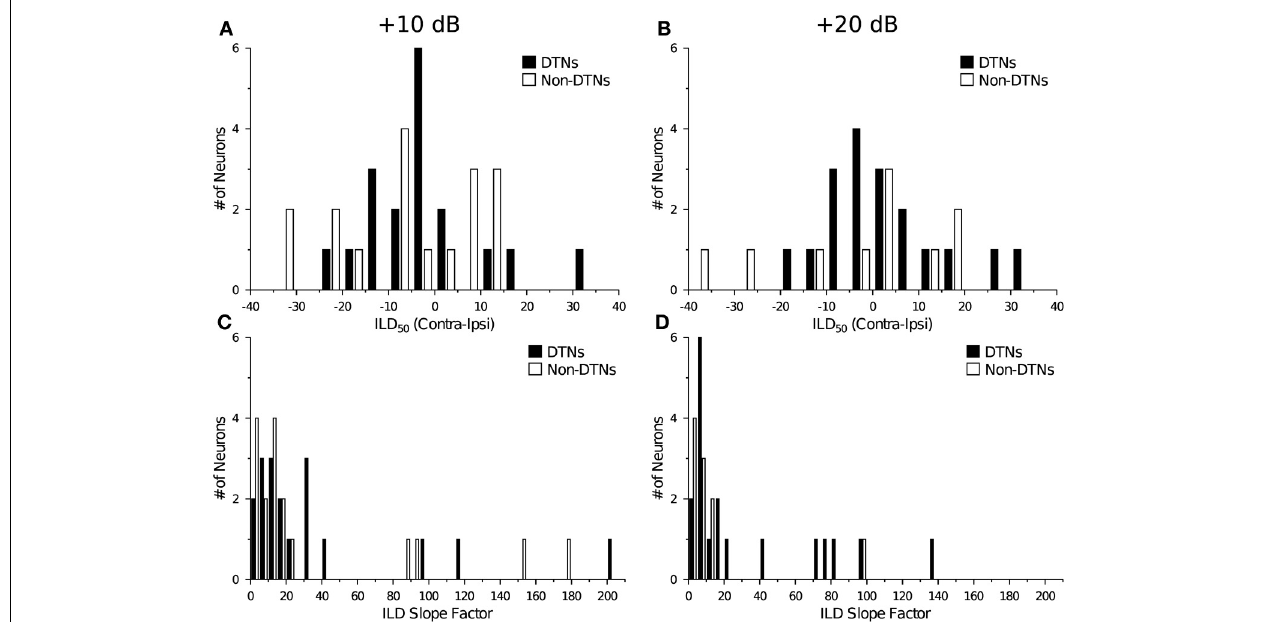
FIGURE 3 | Histograms comparing the distributions of ILD 50 values and slope factors of DTNs and non-DTNs recorded at two suprathreshold levels. The distributions of ILD 50 values for DTNs and non-DTNs were not significantly different at either (A) + 10dB or (B) + 20dB (re threshold). Note that the ILD 50 value from most neurons was centered between 0